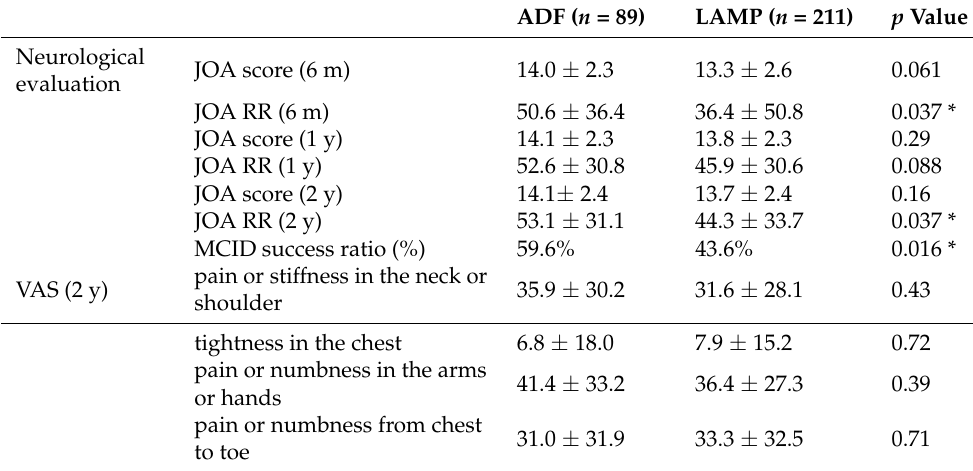
Table 3. Postoperative neurological evaluation in ADF and LAMP (crude analysis).